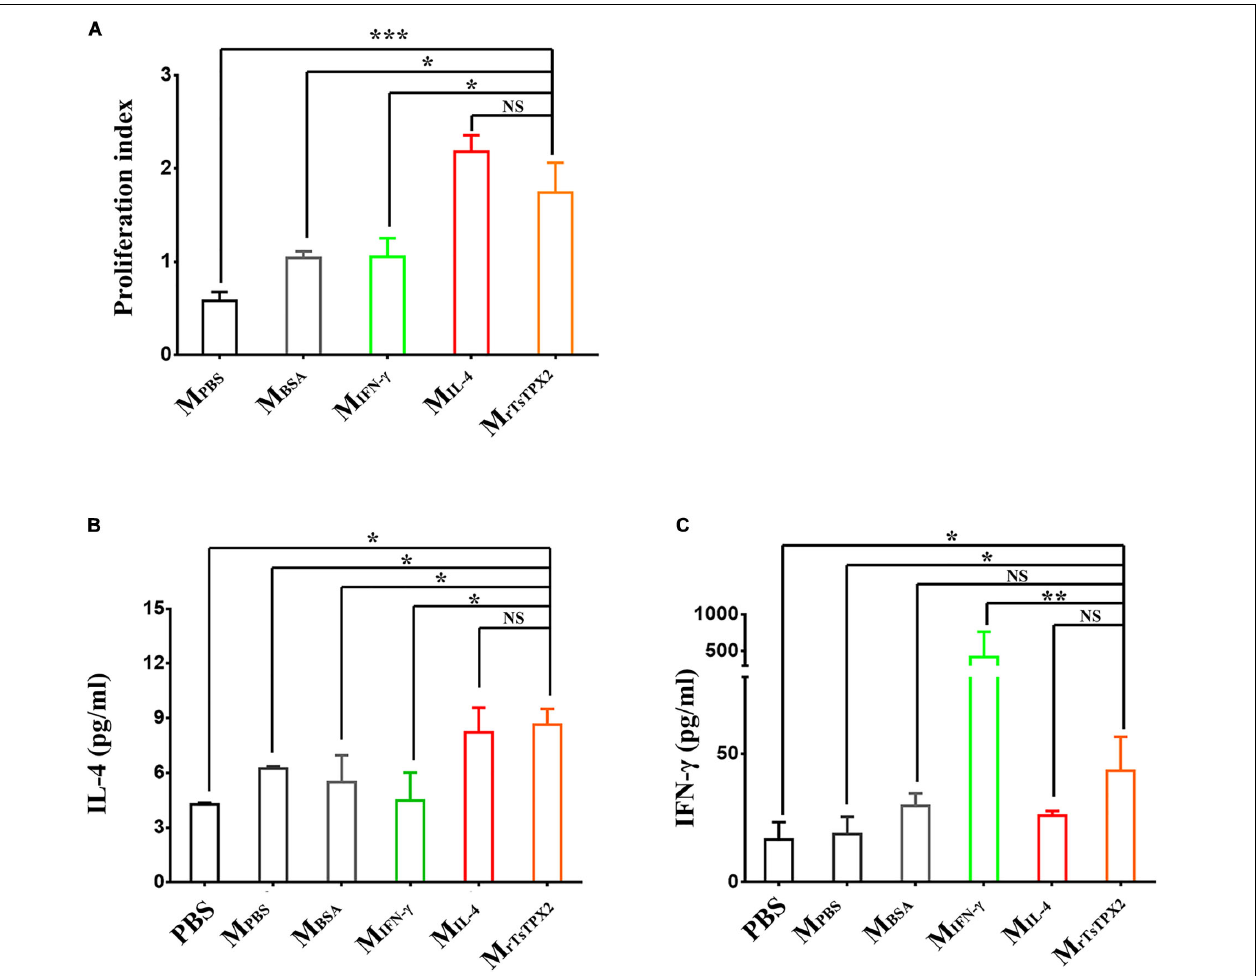
FIGURE 4 | The differentiation and proliferation of CD4 + T cells induced by macrophages. (A) The proliferation index of CD4 + T cells induced by macrophages at 72 h after co-culture, measured by MTs kit. (B) Levels of IL-4 production in supernatant of CD4 + T cells co-cultured with macrophages. (C) Levels of IFN- γ production in supernatant of CD4 + T cells co-cultured with macrophages. CD4 + T cells isolated from healthy BALB/c mice co-cultured with macrophages induced by various stimuli, including PBS as blank control (M PBS ), IL-4 as M2 positive control (M IL − 4 ), INF- γ as M1 positive control (M INF − γ ), BSA as mock control (M BSA ) or rTsTPX2 (M rTsTPX2 ). The experimental group PBS representative CD4 + T cells dealing with PBS. Statistical analysis was performed with Student’s t -test, and data are presented as mean ± SDs (representative of three experiments). *** P < 0.001, **0.001 < P < 0.01, *0.01 < P < 0.05, NS, not significant. n > = 3 mice per group.